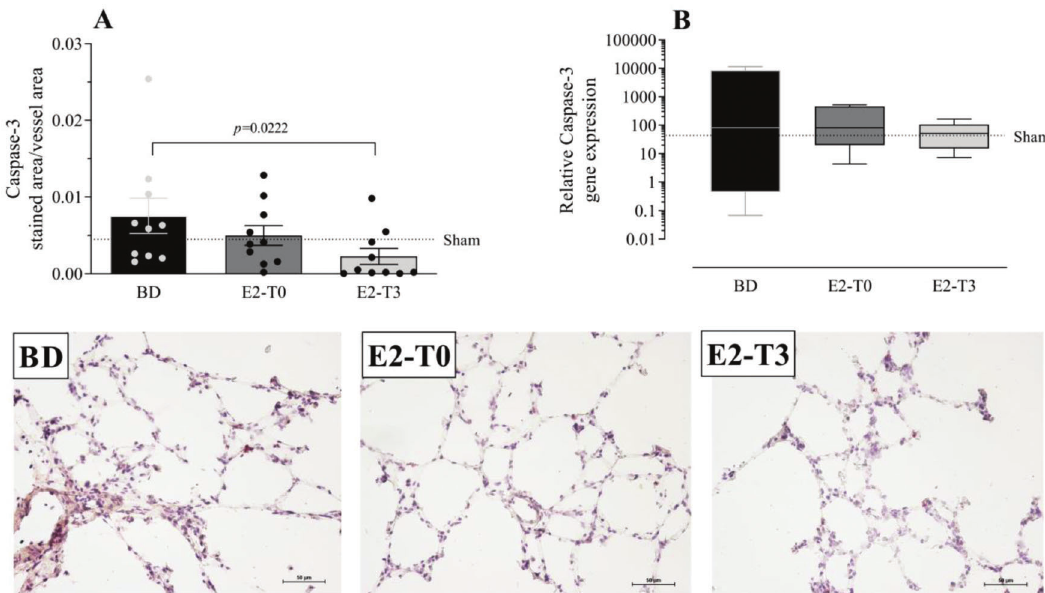
Figure 7 - Lung gene (A) and protein (B) expression of caspase-3 with photomicrography of the immunohistochemical reaction. Female rats were separated in groups: sham animals as control, BD animals subjected to brain death (BD), E2-T0 animals subjected to BD and treated with 17 b -estradiol (E2) starting after BD confirmation, and E2-T3 animals subjected to BD and treated with E2 3h after BD confirmation. (A) Data are expressed as mean ± SEM from 5 photos/sample, 2 samples/animal, 5 animals/group. (B) Data expressed as median and 95% percentile interval from 6 animals. Kruskal-Wallis p =0.0328 (A) and p =0.7793 (B).